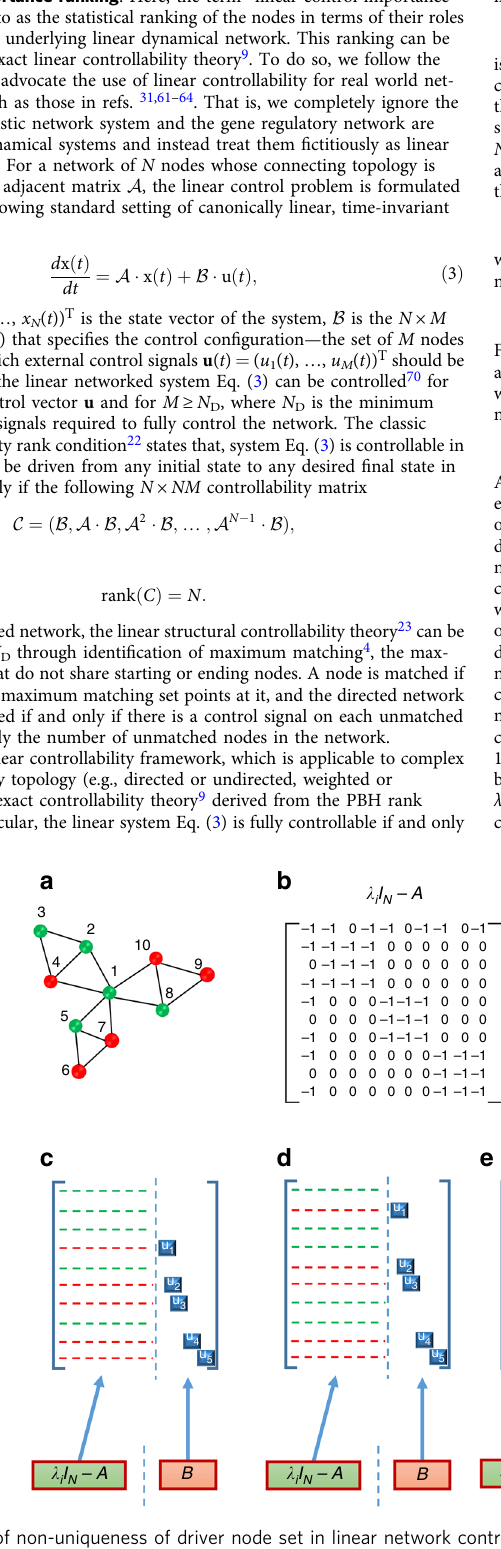
Fig. 6 Illustration of non-uniqueness of driver node set in linear network control. a A 10-node undirected network. Five eigenvalues of the network connection matrix are identical: λ = − 1, so its algebraic multiplicity is fi ve. The geometric multiplicity of this eigenvalue is the number of linearly dependent rows in the matrix λ , which can be determined through elementary column transforms. b The matrix λ and its representation after a series i I N (cid:2) A i I N (cid:2) A of elementary column transforms. The fi rst, second, third, fi fth, and eighth rows are distinct from all other rows, so they are linearly independent. The fourth, sixth, seventh, ninth, and tenth rows are linearly dependent rows. Because there are fi ve linearly independent and fi ve linearly dependent rows, the number of ways to choose the latter is 54. c – f Four distinct ways to choose the control input matrix to make the rank of the matrix λ i I N (cid:2) A ; B ten. For this small network of size ten, any one of the nine out of the the ten nodes can be chosen to be a driver